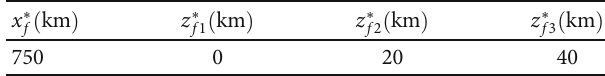
Table 2: Fast trajectories generate di ff erent terminal